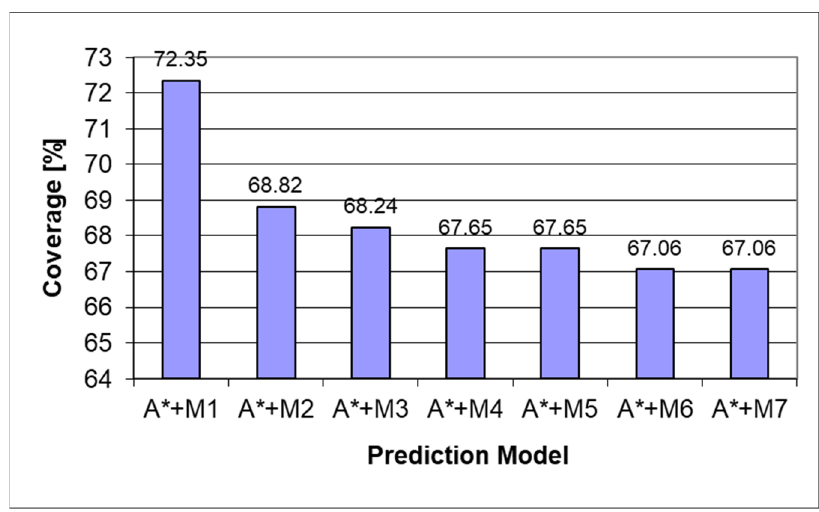
Figure 9. Predictor coverage graph for the perfect heuristic on the “Workers” dataset.